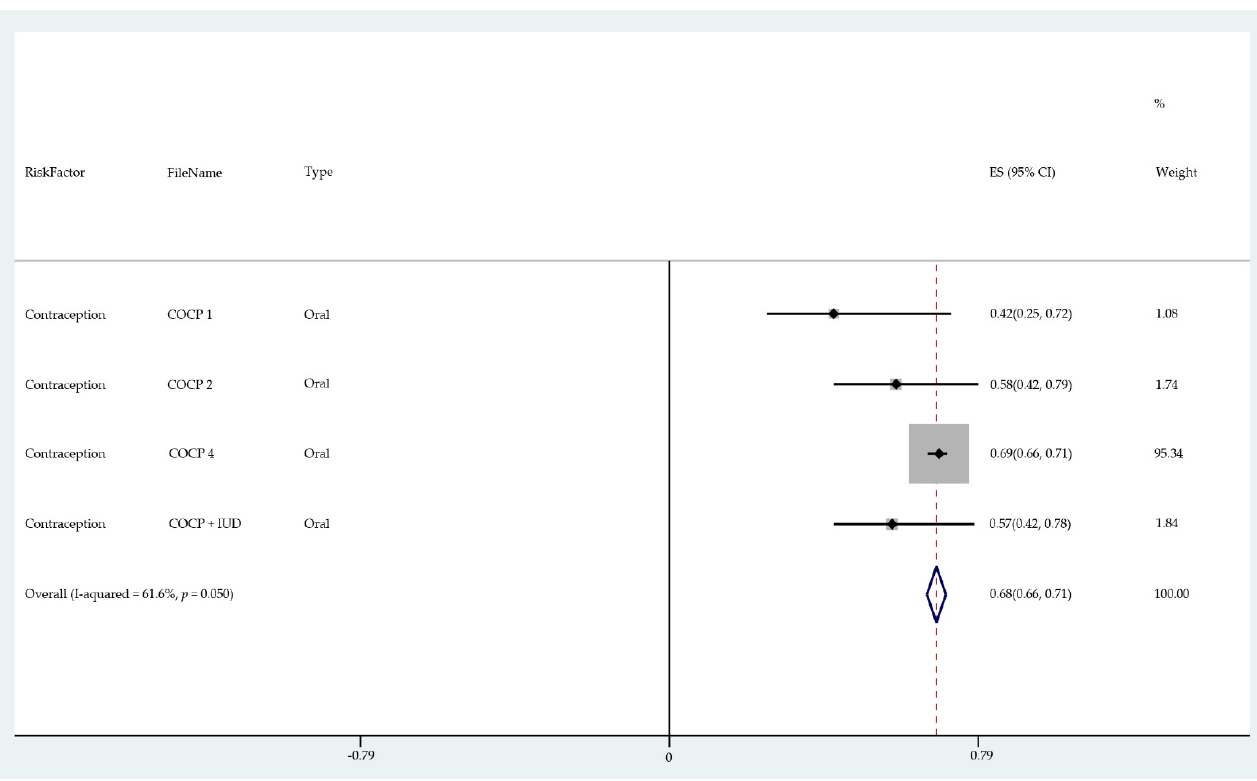
Figure 8. Forest plot to show risk of reproductive factors/null parity.